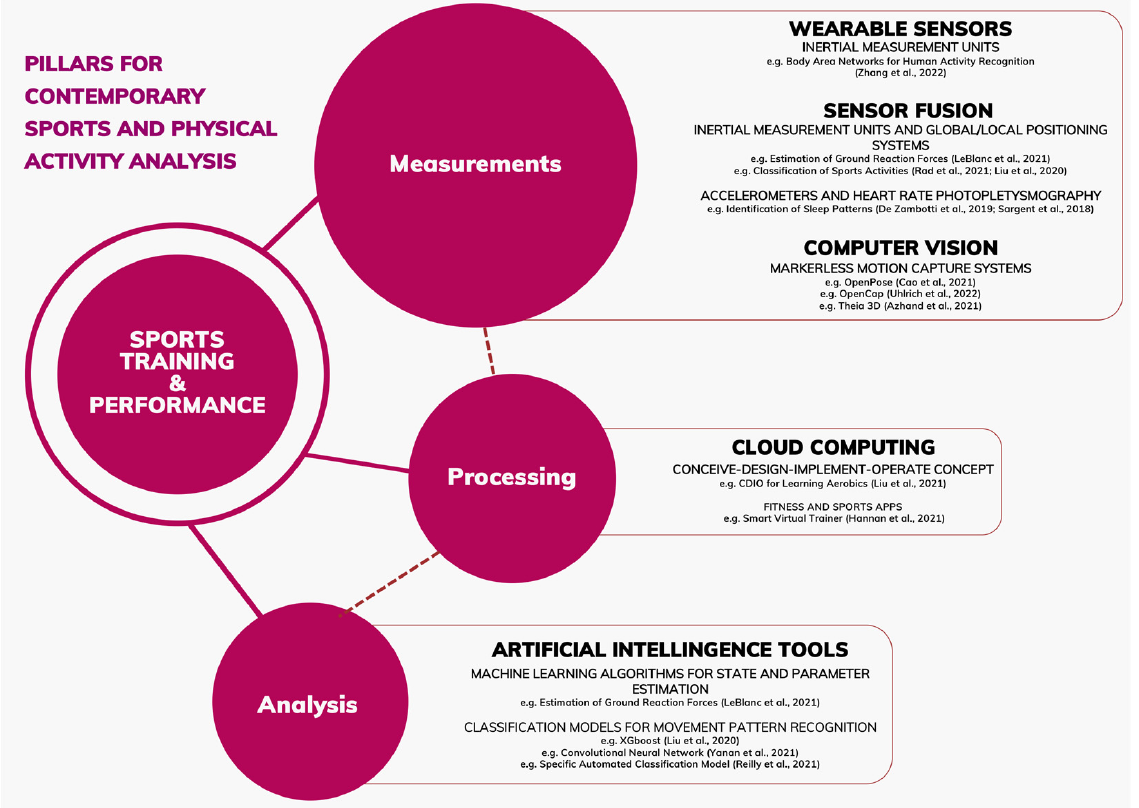
Figure 1. Current methods applied to the analysis of training and performance of sports and physical activity-related issues. Examples from the measurement methods described are in Zhang et al. [2], LeBlanc et al. [3], Rad et al. [4], Liu et al. [5], De Zambotti et al. [6], and Sargent et al. [7]. For methods of processing, current examples are described in Liu et al. [8] and Hannan et al. [9]. Finally, for analysis methods, examples are described in LeBlanc et al. [3], Yanan et al. [10], and Reilly et al. [11].